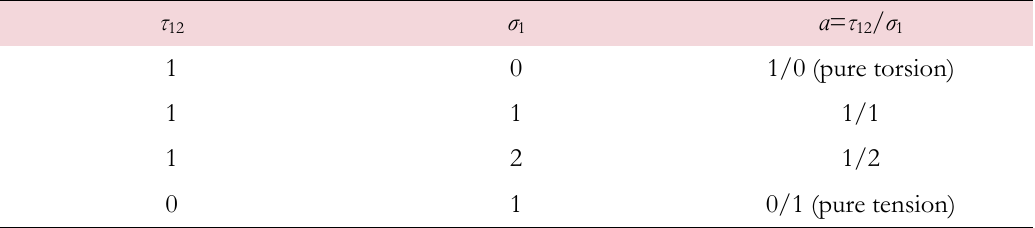
Table 2: Definitions of combined stress ratio α